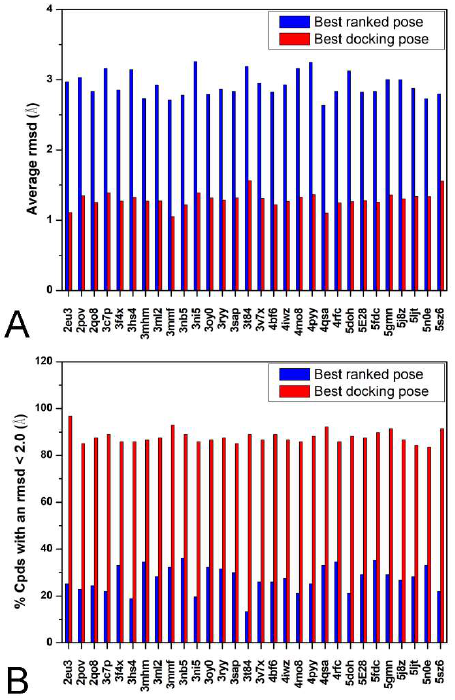
Figure 1. Results of the cross-docking study. For each carbonic anhydrase II (CAII) protein, the average root-mean-square deviation (aRMSD) ( A ) and the percentage of poses with a RMSD less than 2.0 Å ( B ) are reported for both the best ranked pose (blue) and the best binding disposition among the 100 generated docking poses (red).